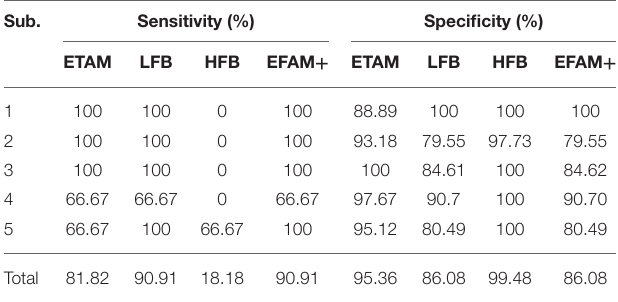
TABLE 5 | Summary of statistical